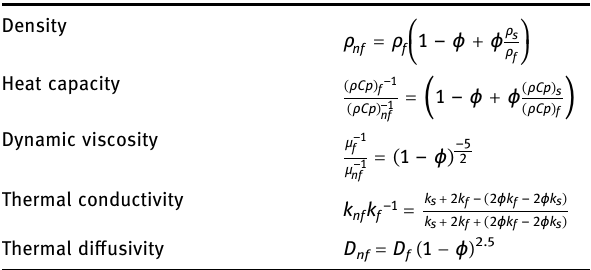
Table 2: The thermophysical properties of Al 2 O 3 /water ( see Khashi ’ ie et al. [ 39 ])